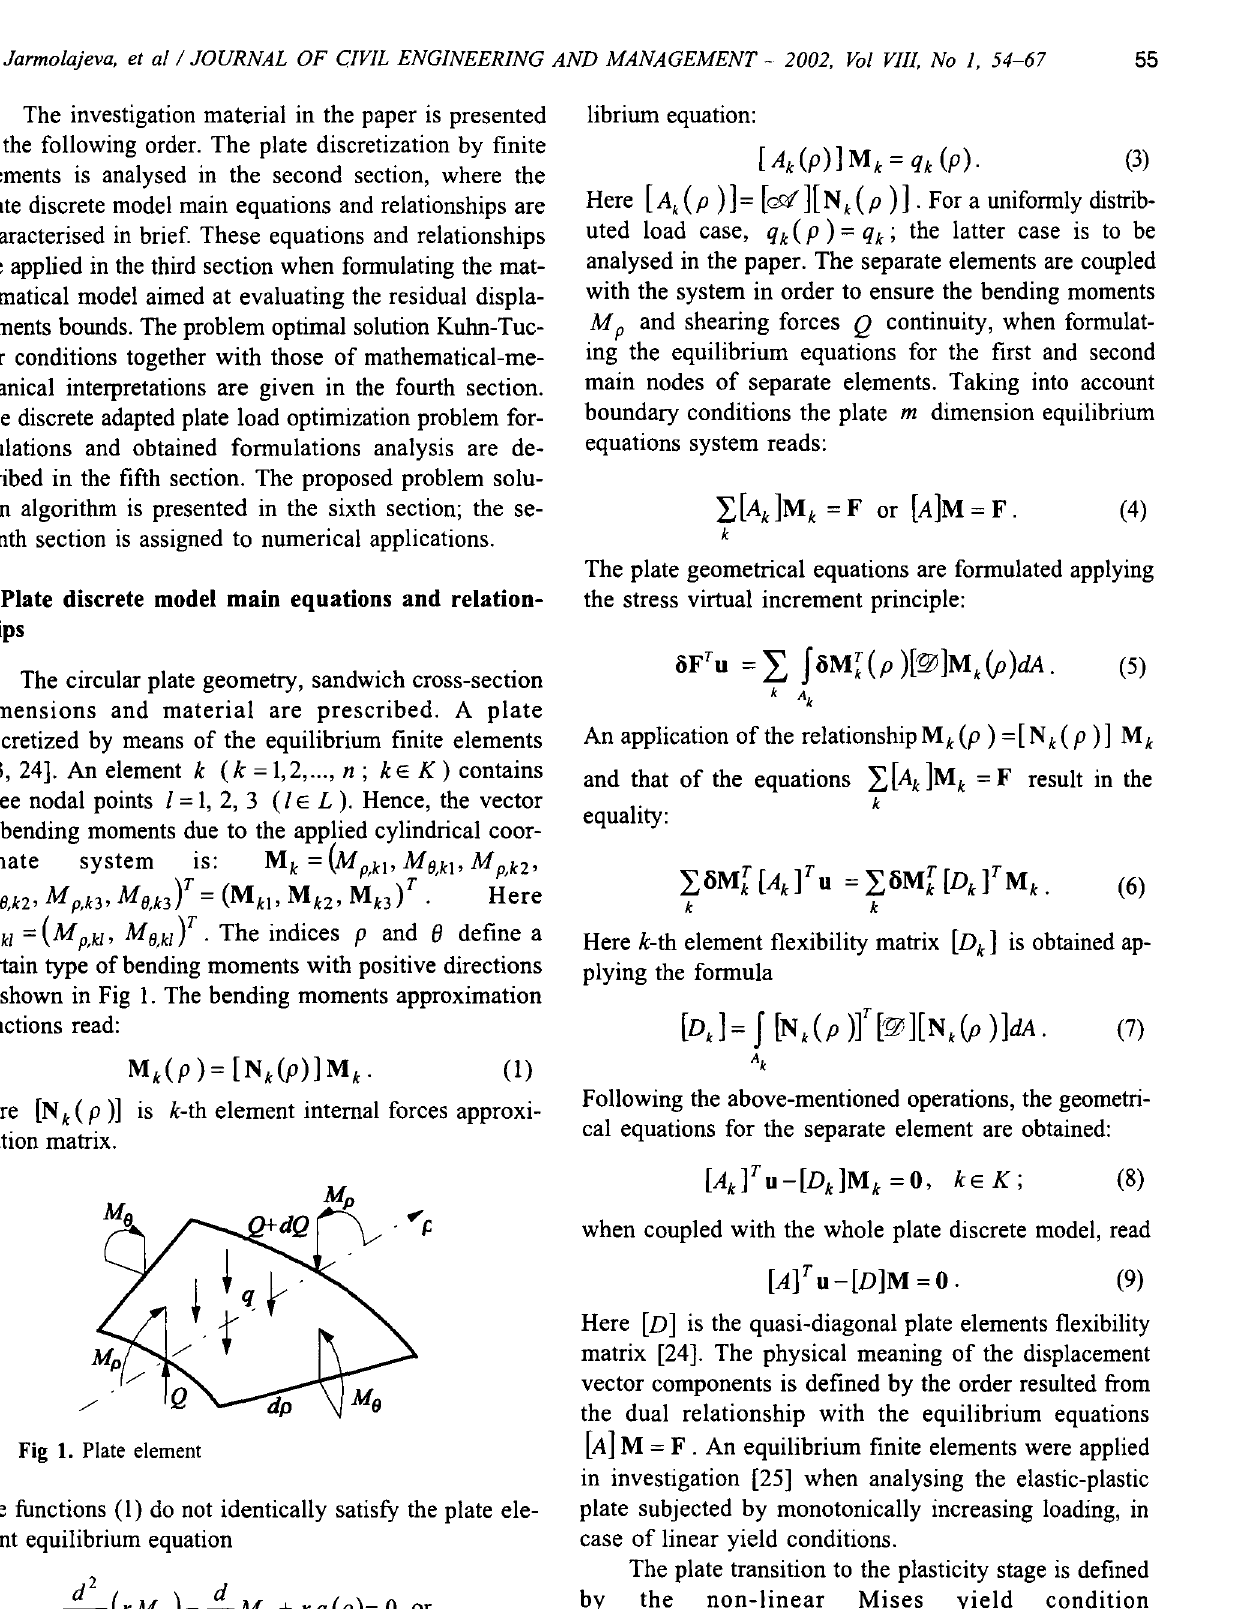
Fig 1. Plate element The functions (I) do not identically satisfy the plate ele ment equilibrium equation